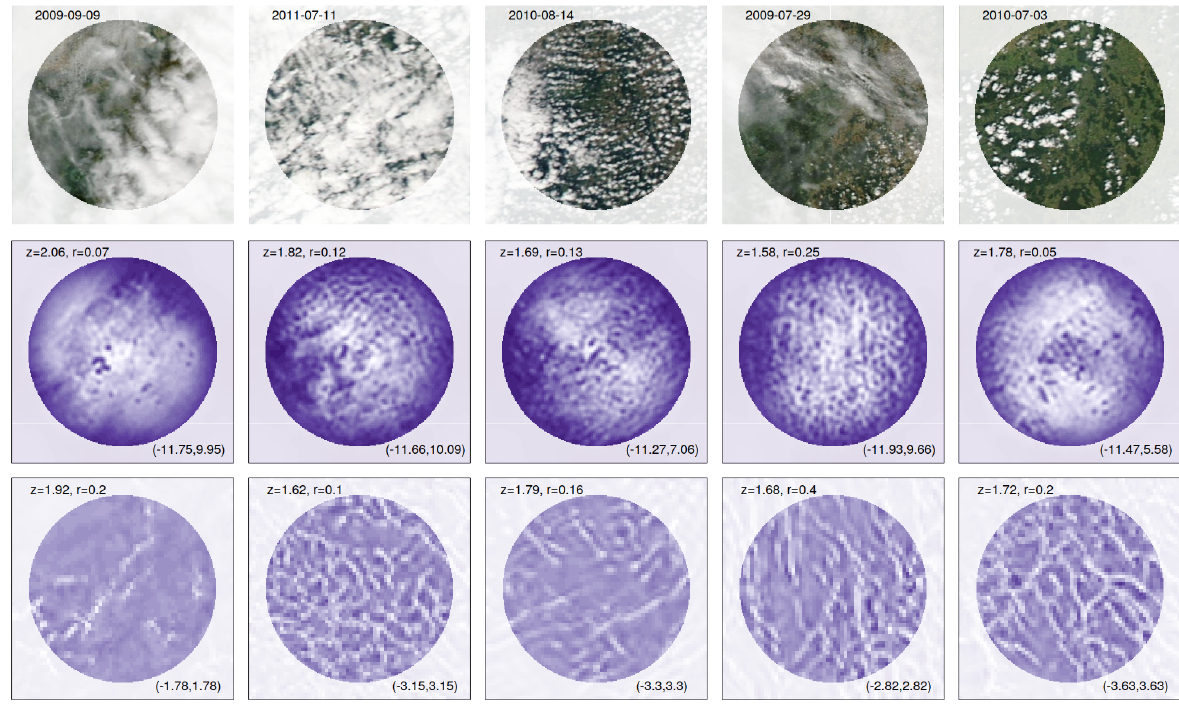
Figure 7. Randomly selected examples from the set of available non-rainy 12:00UTC radar images at Flechtdorf. Top row: Aqua MODIS snapshots (http://wvs.earthdata.nasa.gov, last access: 2 November 2021, timing only approximately matches 12:00UTC). Middle: RADOLAN RX reflectivity. Bottom: COSMO-REA2 level-45 divergence. Light colors indicate high reflectivity and convergence, respec- tively. Numbers in the top left corner indicate the analyzed scale and anisotropy; the range of reflectivity and divergence values is given in the bottom